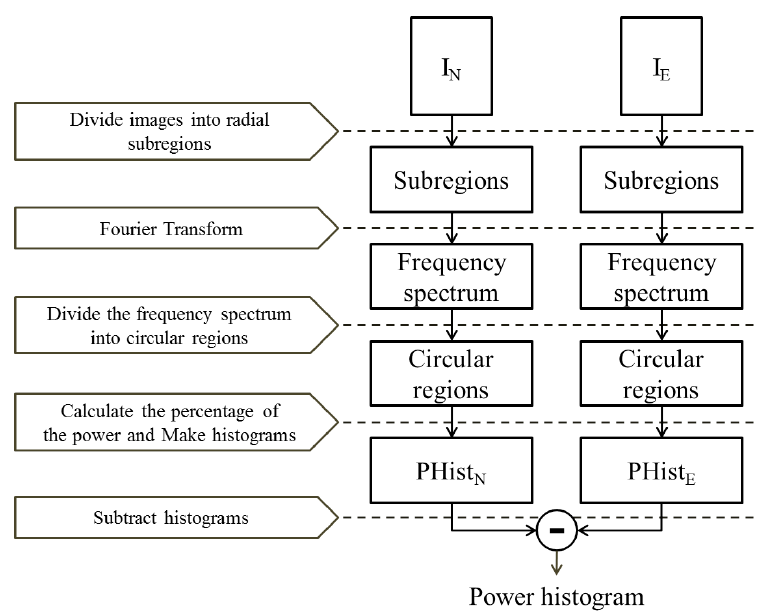
Figure 11. Flowchart of power histogram feature extraction.